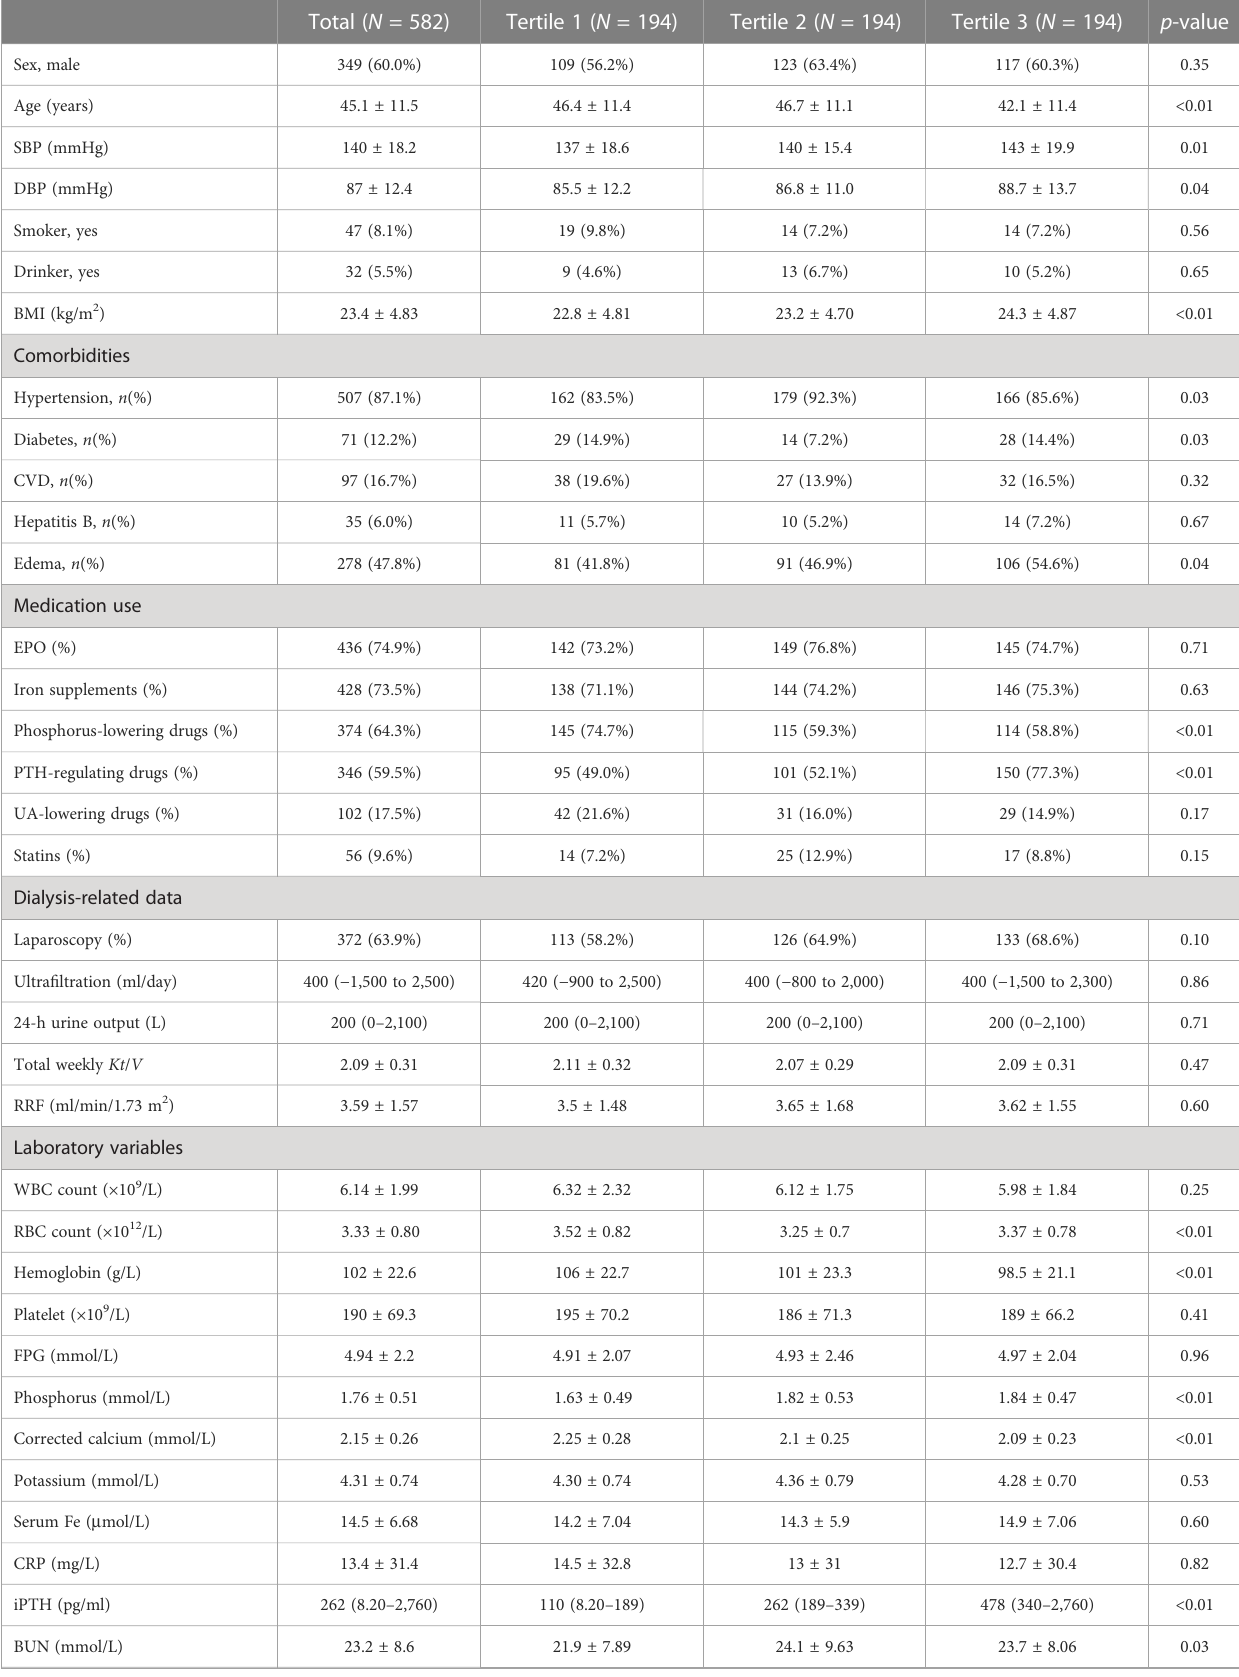
TABLE 1 Baseline demographic and clinical characteristic of the study population by serum intact parathyroid hormone (iPTH)